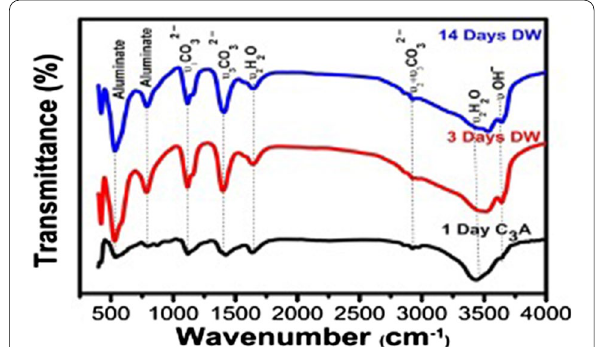
Fig. 4 FTIR spectra of the C 3 A composite samples cured under distilled water for 1, 3 and 14 days